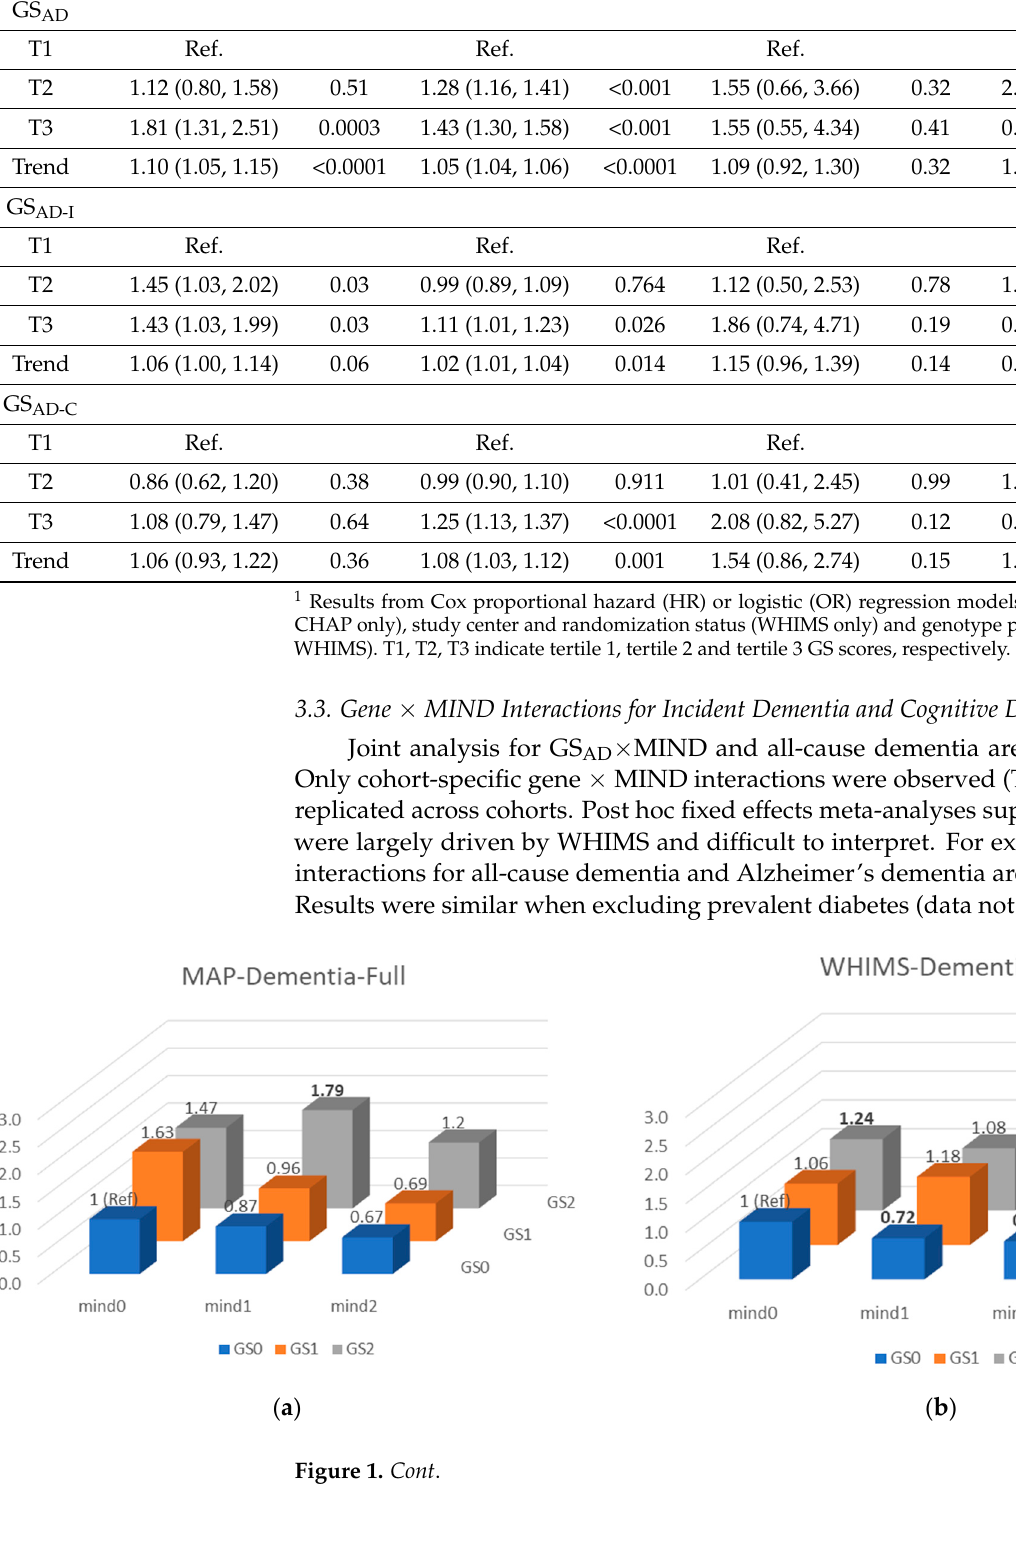
( d ) Figure 1. Joint analysis of GS AD ×MIND and all-cause dementia. Results from Cox proportional haz- ard (HR, MAP (a)/ WHIMS (b) ) or logistic (OR, CHAP (c,d) ) regression models adjusted for age, sex (MAP, CHAP only), study center and randomization status (WHIMS only), education, income, global cognition score, late-life cognitive activity (MAP, CHAP only), history of diabetes, hyperten- sion, stroke and heart disease; smoking, calorie intake, BMI, depressive symptoms, physical activity, genotype platform (MAP) or PCs (CHAP, WHIMS). Mind(GS)1, Mind(GS)2, Mind(GS)3 indicate tertile 1, tertile 2 and tertile 3 MIND adherence (GS) scores, respectively. Significant HR/ORs are bold-faced. Table 5. Gene × MIND Interaction Tests 1 . Outcome Interaction Term